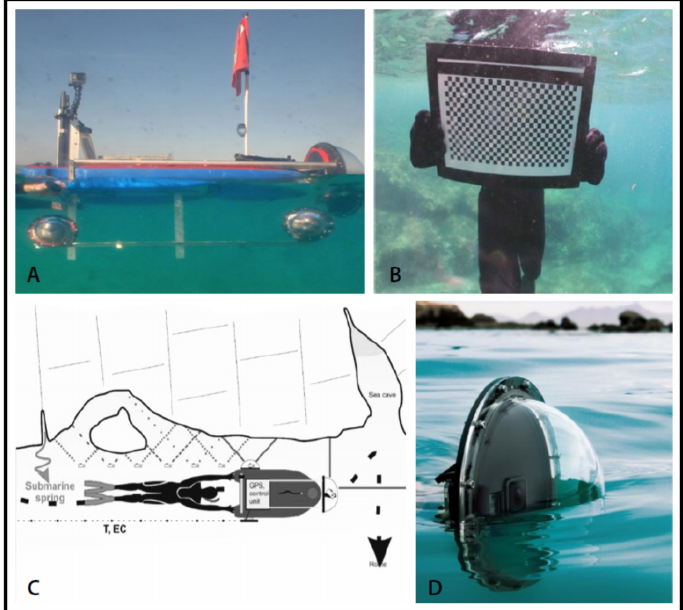
Figure 6. ( A ) The configuration of the cameras hosted on the raft used for the photogrammetric acquisition; ( B ) Underwater/subaerial photogrammetric target used to calibrate the distortion index due to surface roughness in underwater photogrammetry; ( C ) Sketch of the acquisition of time-lapse images along the coastal routes. The swimming is carried out at 1 ± 0.5 m from the shore, at a speed of about 1 to 2 km/h. The camera positioned within the dome at the front of the raft, inclined at 45° with respect to the coastline, is used to document the survey; ( D ) The cameras within the domes mounted laterally are positioned at –0.5 m below the waterline and at 1 m above.